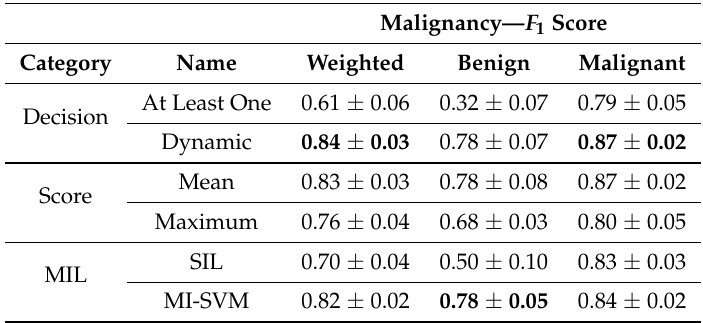
Table 6. Results for the patient-level classification for Malignancy (LM/LMM and BCC) according to the different methods from Section 2.4. For Malignancy and LM/LMM, the table provides a weighted average F 1 score and individual F 1 score for the benign and the malignant